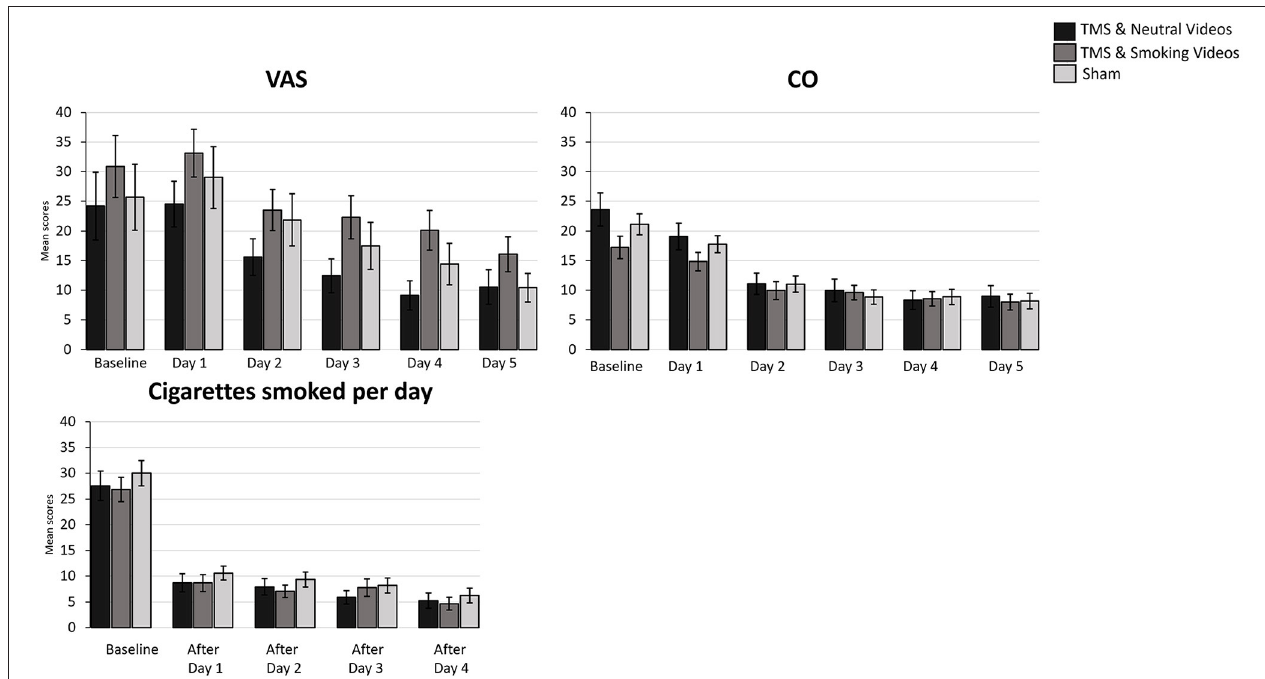
TABLE 3 | Results of paired sample t -test for the number of cigarettes smoked per day.